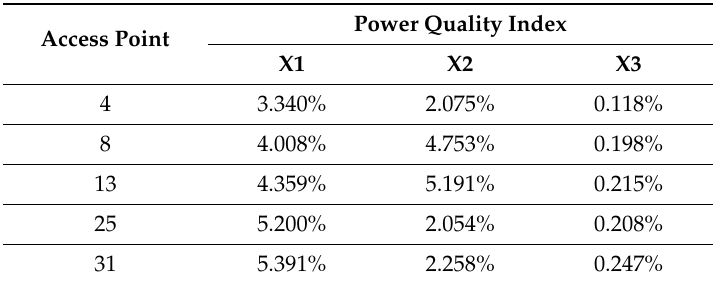
Table A3. Data of various indicators of power quality.